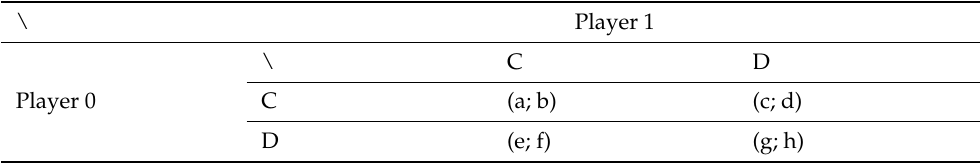
Table 1. General matrix representation of a game with two players and two strategies.